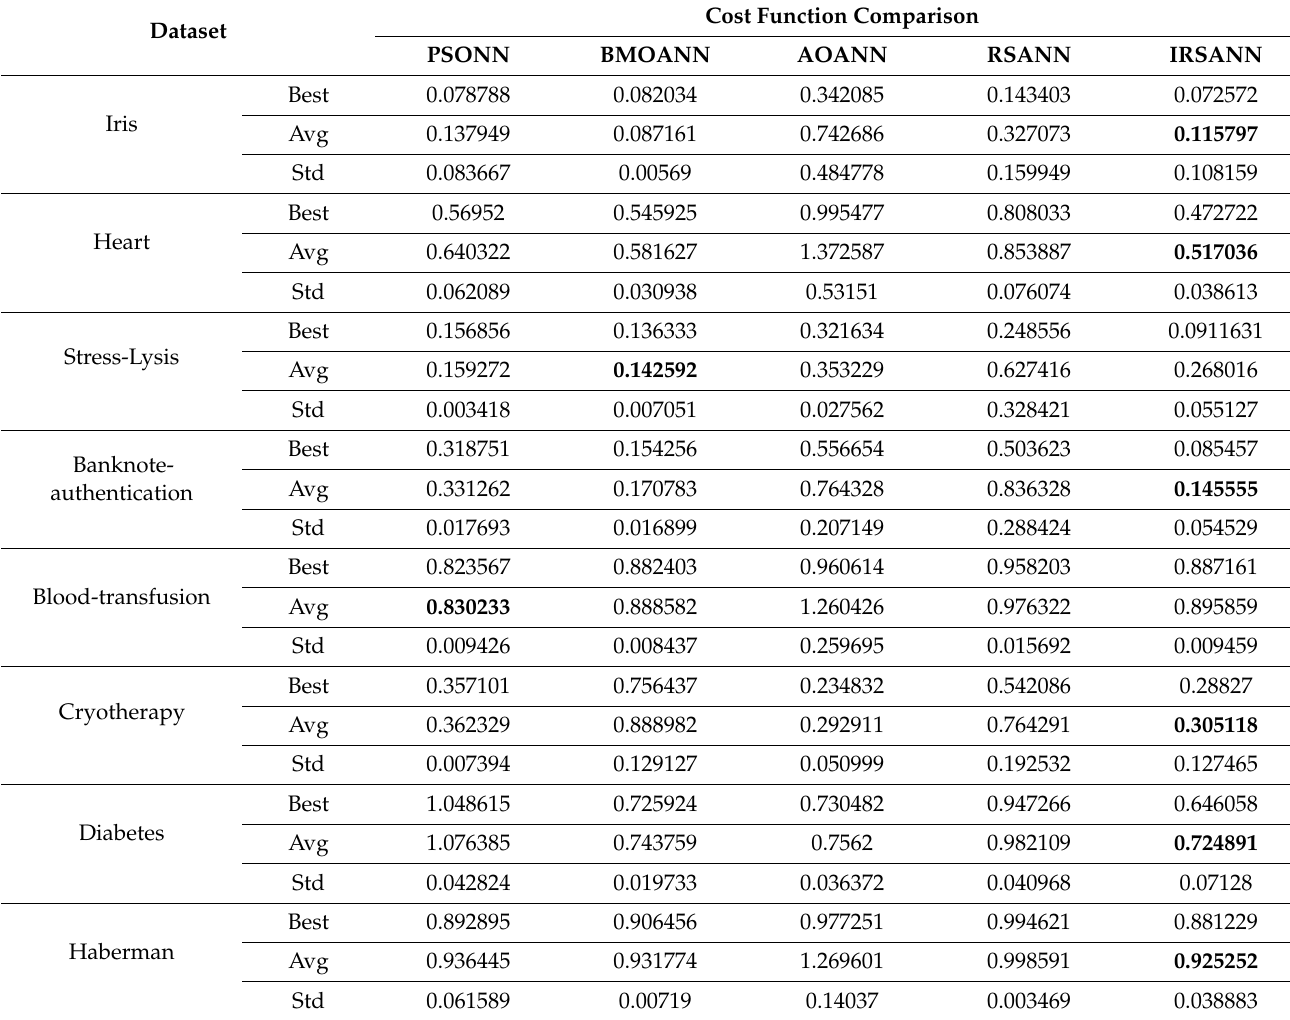
Table 9. Cost evaluation of classification